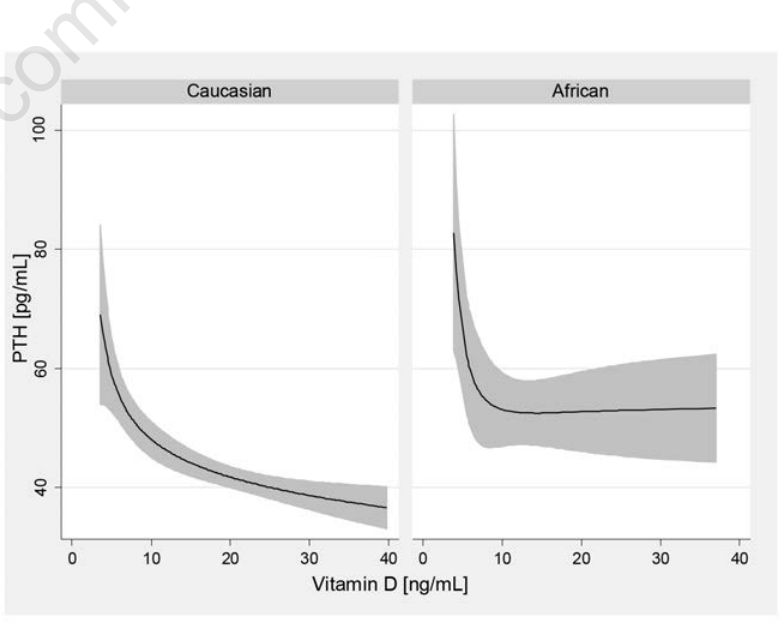
Figure 1. Fitted polynomial plots on the relation of vitamin D and PTH concentrations. The black line represents the fitted, polynomial smoothened association of vitamin D (25-OH-Cholecalciferol) with PTH concentration per ethnicity. The grey area represents the predicted 95% confidence